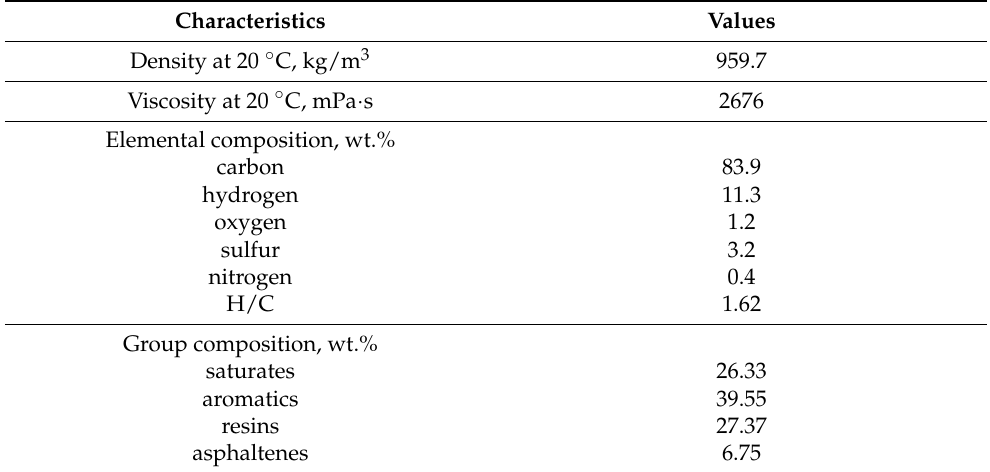
Table 1. The physical and chemical properties of Ashalcha heavy oil.